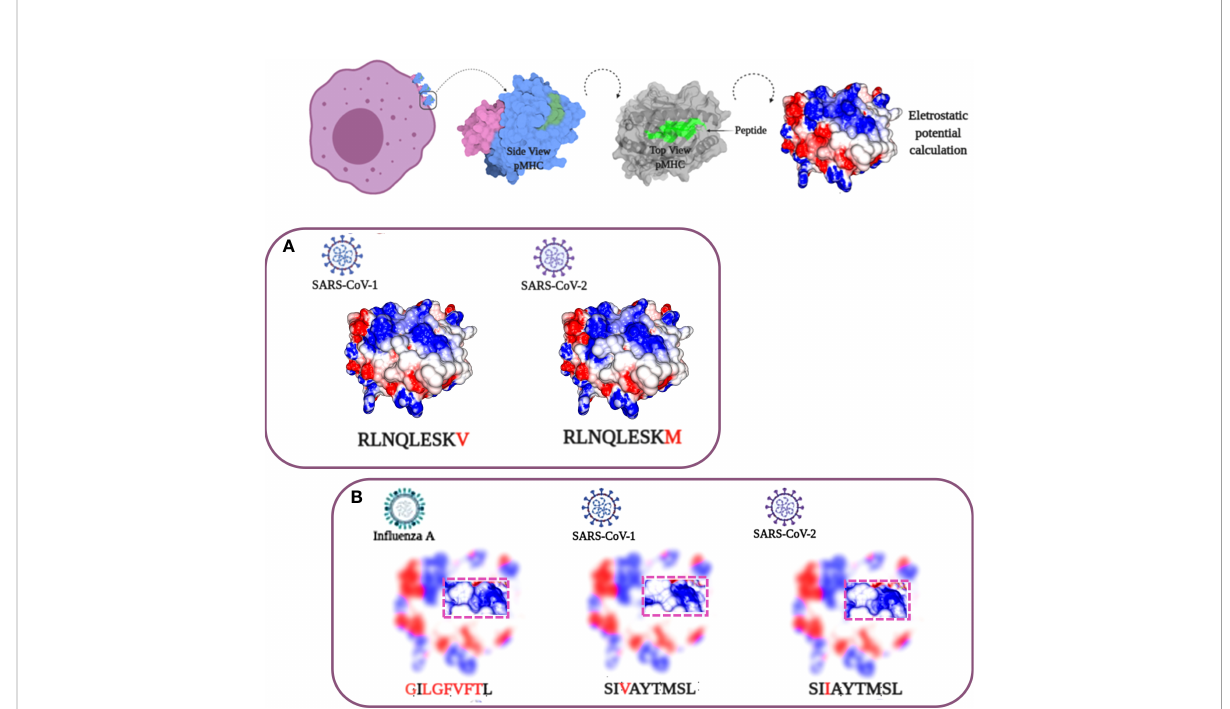
FIGURE 2 Structural analysis of SARS-CoV HLA-A*02:01 epitopes. At the top, a progressive scheme demonstrating the analyzed TCR-interacting surface. From left to right: 1) the MHCs in the cell membrane; 2) a side view of pMHC with alpha chain in pale blue, B2-microglobulin in pale purple, and the peptide in green; 3) a top view of pMHC with the peptide region highlighted in green, and 4) the pMHC surface with electrostatic potential distribution and topography, the main elements involved in immune response stimulation. Negative charge values colored in red and positive ones in blue, with neutral charges depicted in white (variation from -3 to 3 passing through zero). (A) SARS-CoV peptide sequences showing high similarity in sequence and molecular features. (B) SARS-CoV SI V AYTMSL/SI I AYTMSL sequences presenting subtle differences. A structural comparison with an unrelated in fl uenza IAV GILGFVFTL epitope demonstrates an even greater molecular identity with the SI I AYTMSL SARS- CoV-2 peptide compared with its SARS-CoV-1 cognate sequence. The image of the cel in the top was Created with